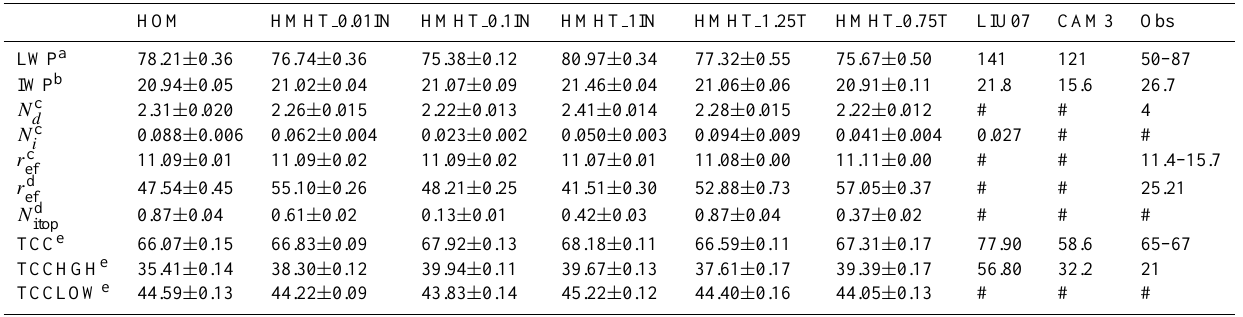
Table 2. Annual global mean cloud properties and their interannual variations (standard deviations).